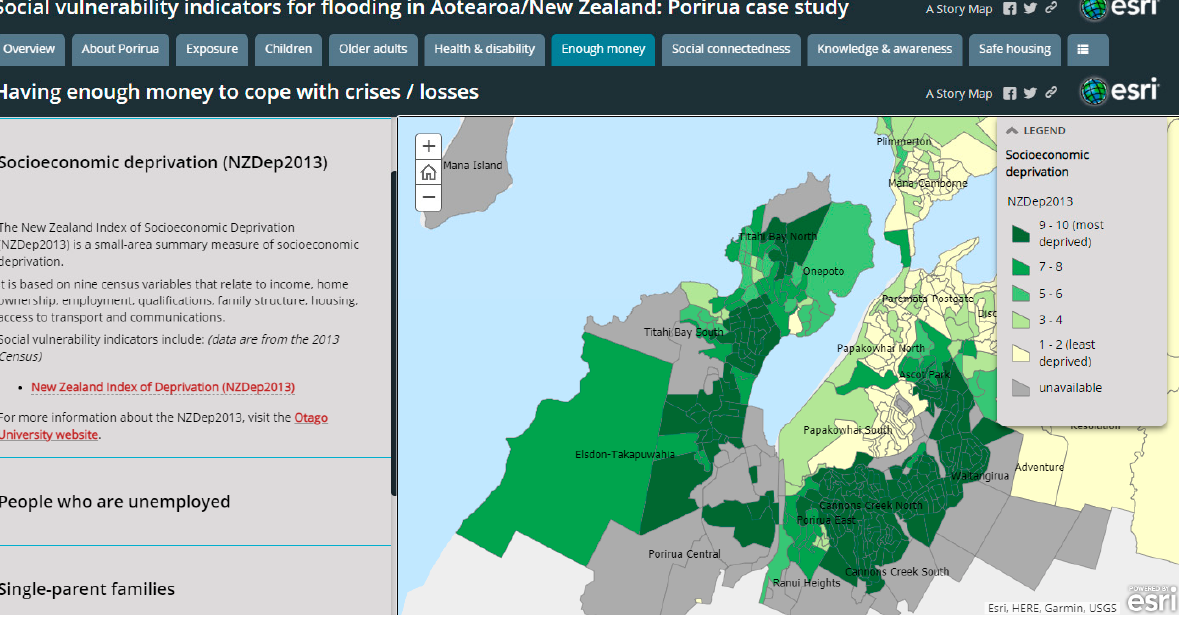
Figure 5. Screenshot of the online interactive map (Story Map) of social vulnerability indicators for Porirua, showing NZDep2013 at the meshblock level.